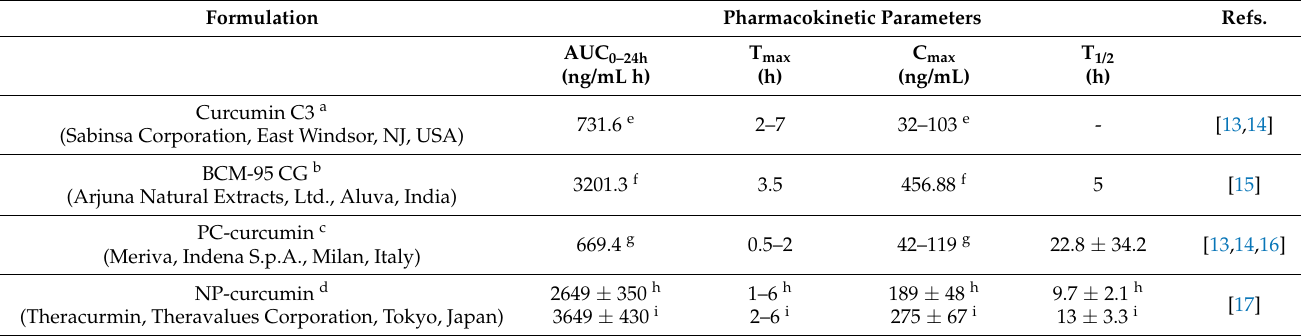
Table 1. Pharmacokinetic parameters of main curcumin